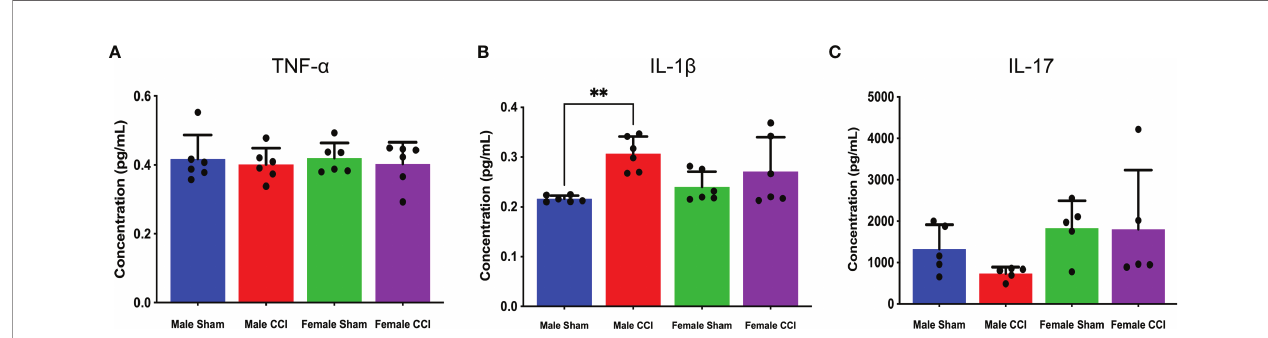
FIGURE 5 | Cytokine ELISAs. The above charts depict the average concentration of TNF- ⍺ (A) , IL-17 (B) , and IL-1 b (C) detected in cerebral tissue culture from individual ELISAs. TNF- ⍺ concentrations were mostly equivalent across all groups. The female groups recorded higher IL-17 concentrations than the male groups, but there was no signi fi cant difference between the female CCI group and the female sham group (B) . IL-1 b concentrations were elevated in the CCI groups, but there was no signi fi cant difference between the female CCI or male CCI groups (C) . **p